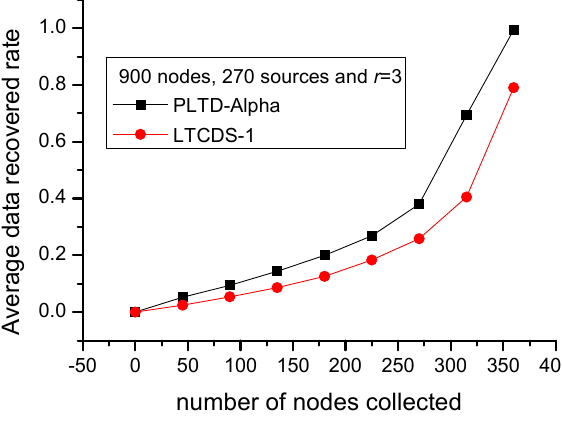
Figure 13. Data recovery performance in a disaster network with n = 900, k = 270.